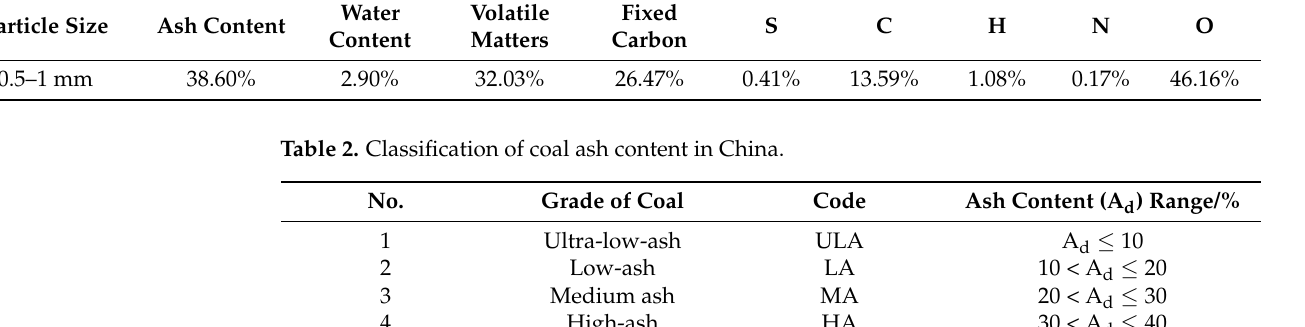
Table 1. Proximate analysis (dry ash free basis) and ultimate analyses for raw coal in Inner Mongolia. Water Particle Size Ash Content